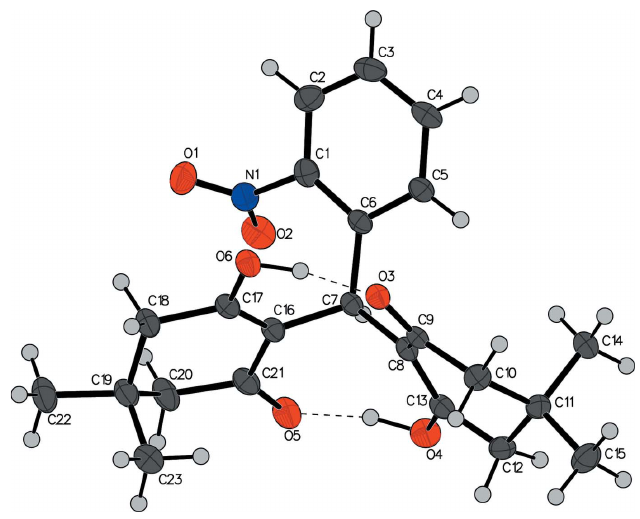
Figure 1 The asymmetric unit of compound I showing the atom-labeling scheme. Displacement ellipsoids are drawn at the 50% probability level. The dashed lines indicate intramolecular O—H (cid:2)(cid:2)(cid:2) O hydrogen